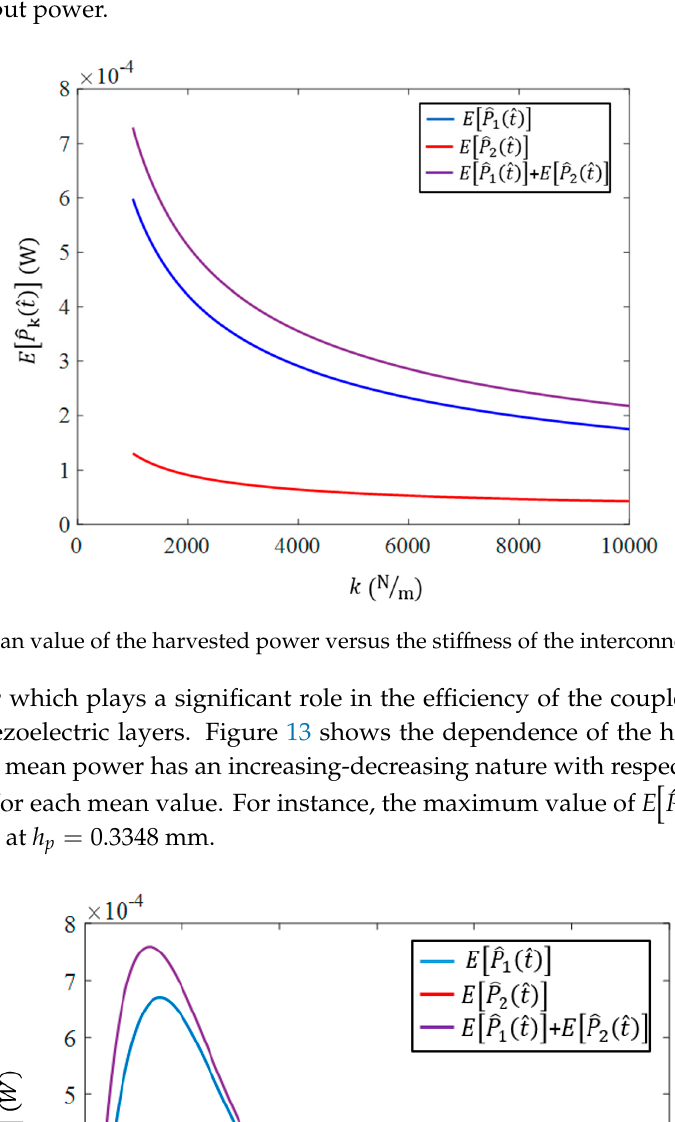
(cid:3046)((cid:2870)) ℎ (cid:3046)((cid:2869)) (cid:3415) .